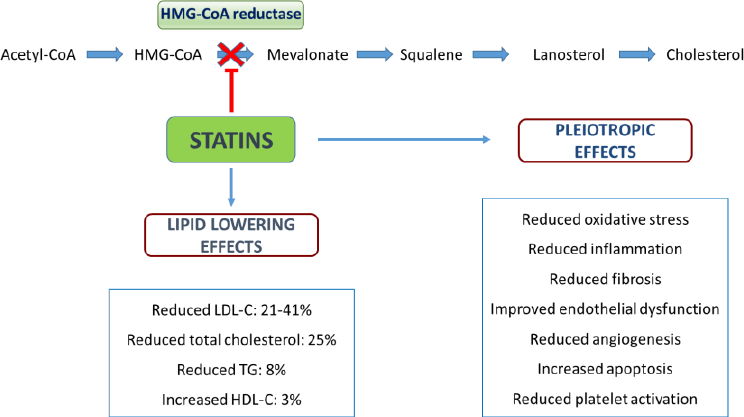
Figure 1. Mechanisms and effects of statins.